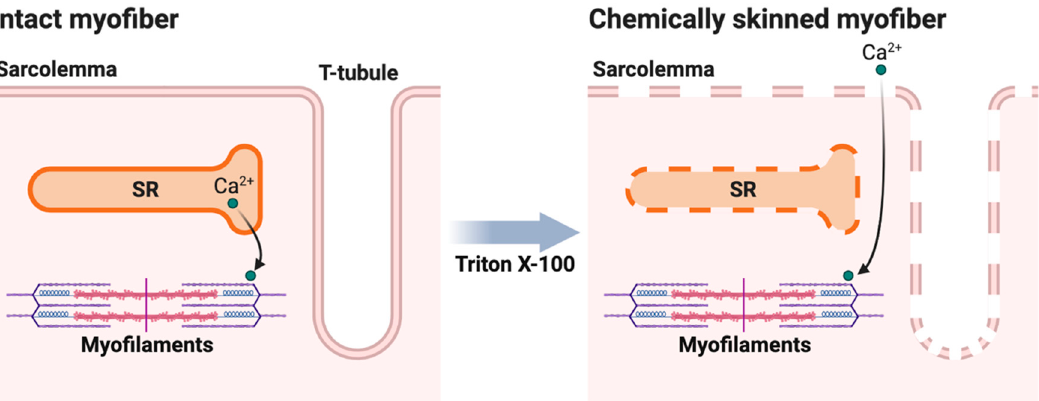
Figure 6. A schematic depiction of chemically skinning a myofiber. Chemical skinning by exposure to Triton X ‐ 100 disrupts all membrane structures of the myofiber: sarcolemma, transverse (T) ‐ tu ‐ bules, and sarcoplasmic reticulum (SR), and leaves only the contractile apparatus (myofilaments) intact. This bypasses the excitation ‐ contraction coupling pathway and calcium (Ca 2+ ) release from the SR, to allow Ca 2+ ‐ activation properties of the myofilaments to be examined directly. Created with